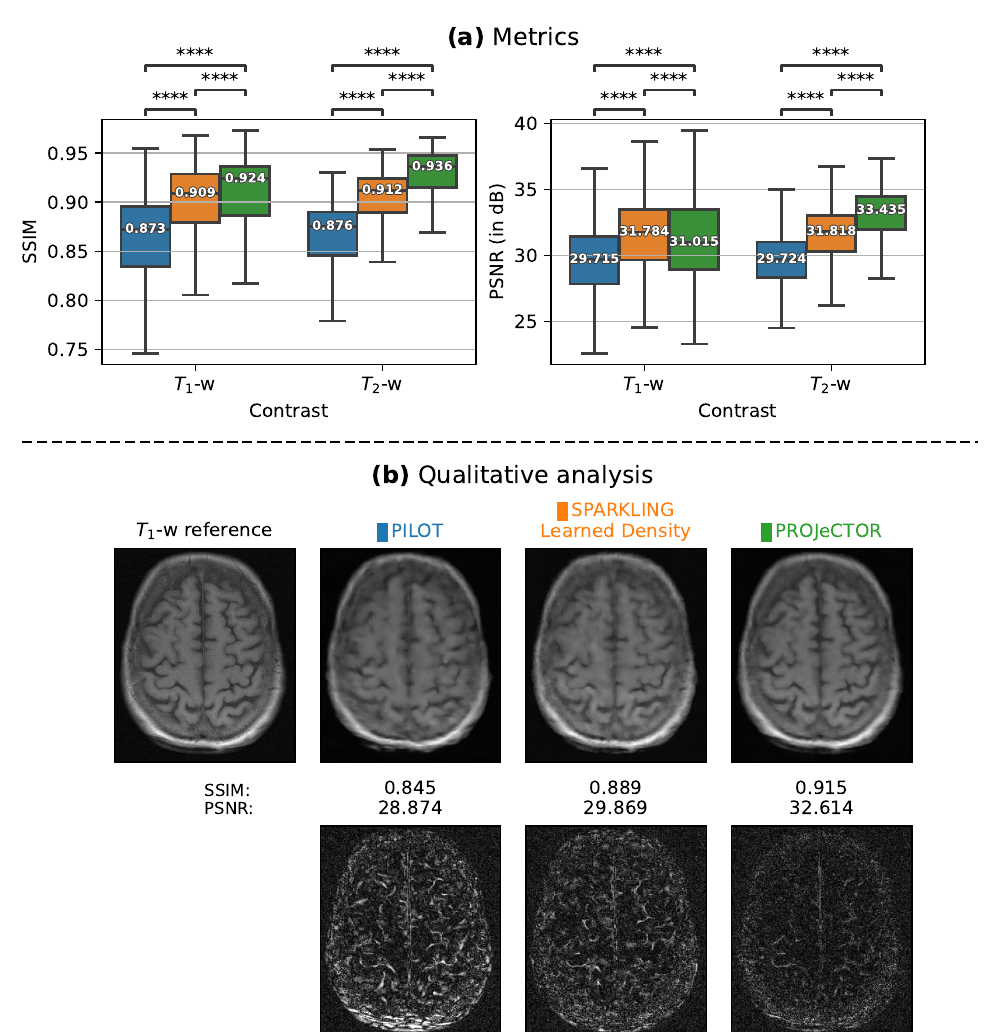
Figure 3. ( a ) Box plots comparing the image reconstruction results on a retrospective study at UF ∆ t = 5) using 512 slices of T = 2.5 ( N c = 16, N s = 512, 1 and T 2 contrasts (fastMRI validation δ t data set) using PILOT (blue), SPARKLING with learned density (orange) and PROJeCTOR (green). SSIMs/PSNRs appear at left/right. The median values of these metrics are highlighted inside the box plots. The significance levels are indicated as a paired t -test and are all significant with p < 10 − 4 (Significance level indicated with **** between groups in box plots). ( b ) Top: T 1 -w reference image and reconstruction results for a single slice from file_brain_AXT1PRE_209_6001221.h5 with corresponding strategies. ( b ) Bottom: The residuals maps, scaled to match and being comparable across